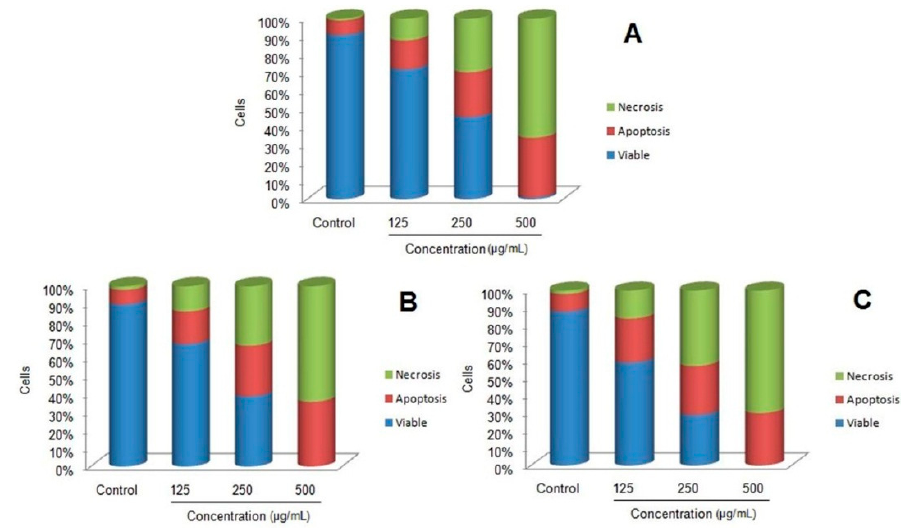
Figure 6. Flow cytometry analysis of untreated and treated 4T1 cells with MnFe 2 O 4 nanoparticles for 24 h ( A ); 48 h ( B ) and 72 h ( C ) stained with acridine orange and propidium iodide (AO/PI).